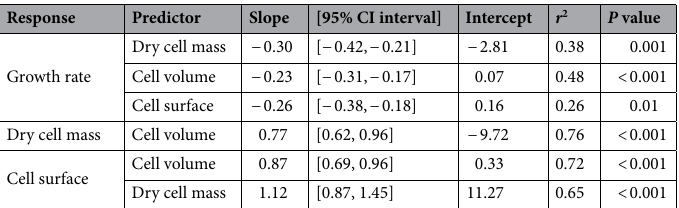
Table 1. Standardized major axis (SMA) regression of population growth rate and traits linked to body size. All variables are log-10-transformed. P value is test of slope (correlation coefficient) against